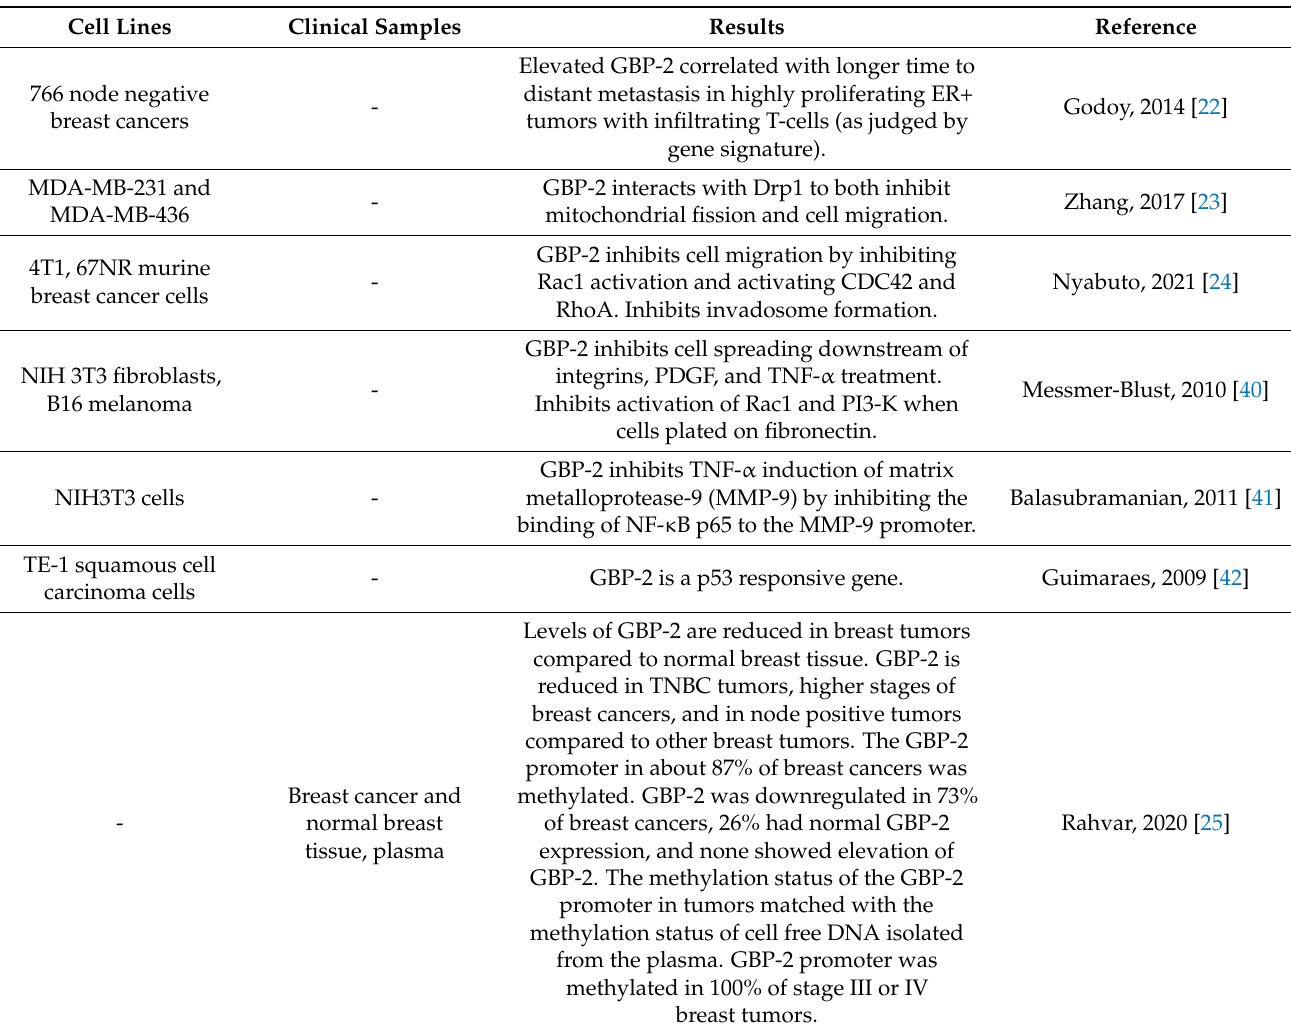
Table 3. Manuscripts addressing GBP-2 and breast cancer. However, it should be noted that the Godoy et al. manuscript listed the incorrect Affymetrix probe set for their analysis of GBP-2 in breast cancer [22]. The probe set they listed was for an Ig light chain